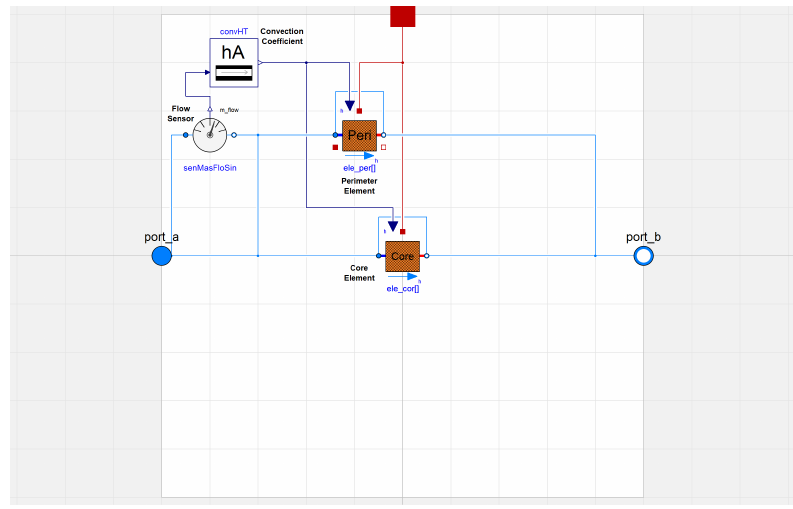
Figure 5. Full model of the PCM heat exchanger in Modelica with core and perimeter elements.